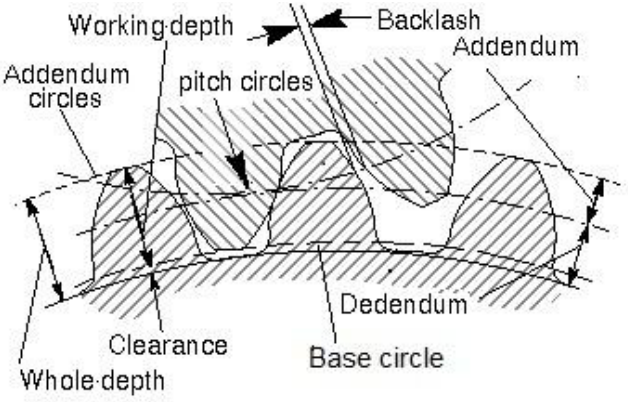
Figure 1. Schematic diagram of two gears